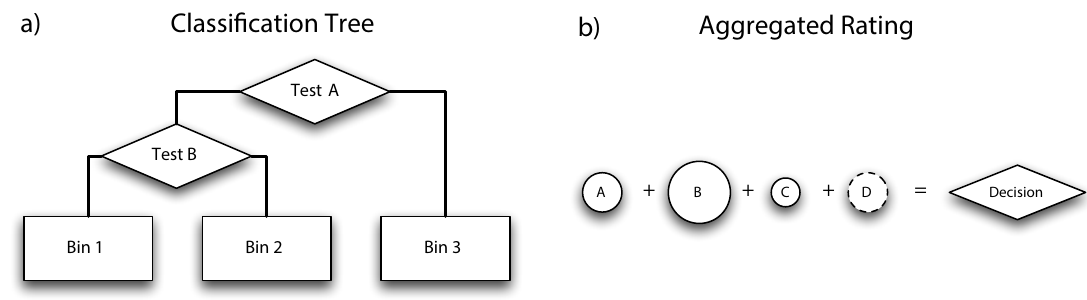
Figure 4. ( a ) Schematic of a the binary classification tree. ( b ) Aggregated rating of continuous